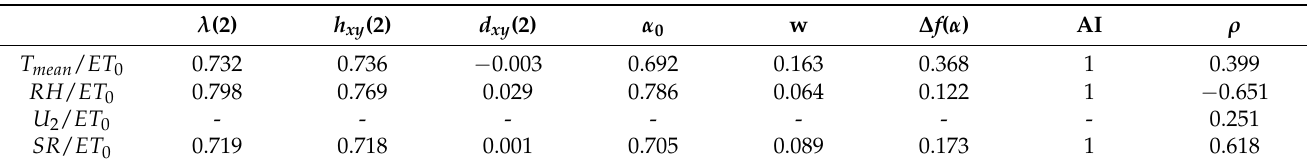
Table 3. MFCCA parameters and Pearson correlation coefficient ( ρ ) at a significance level of 0.01 of the agro-meteorogical series.